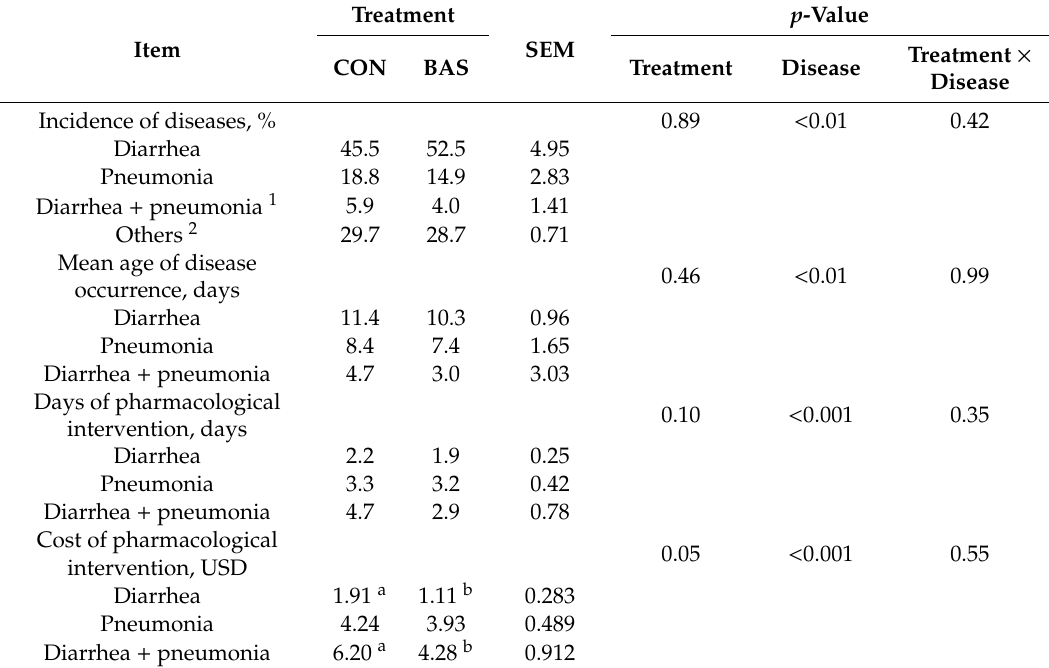
Table 2. Incidence of diseases, mean age of disease occurrence, days of pharmacological intervention required, and cost per head of pharmacological interventions of female Gir × Holstein female calves receiving (BAS; n = 70) or not receiving (CON; n = 70) a bovine appeasing substance every 14 days during pre-weaning and diagnosed with any disease during the experimental period 1 . p -Value Treatment Item SEM Treatment × CON BAS Treatment Disease Disease Incidence of diseases, % 0.89 < 0.01 0.42 Diarrhea 45.5 52.5 4.95 Pneumonia 18.8 14.9 2.83 Diarrhea + pneumonia 1 5.9 4.0 1.41 Others 2 29.7 28.7 0.71 Mean age of disease 0.46 < 0.01 0.99 occurrence, days Diarrhea 11.4 10.3 0.96 Pneumonia 8.4 7.4 1.65 Diarrhea + pneumonia 4.7 3.0 3.03 Days of pharmacological 0.10 < 0.001 0.35 intervention, days Diarrhea 2.2 1.9 0.25 Pneumonia 3.3 3.2 0.42 Diarrhea + pneumonia 4.7 2.9 0.78 Cost of pharmacological 0.05 < 0.001 0.55 intervention, USD Diarrhea 1.91 a 1.11 b 0.283 Pneumonia 4.24 3.93 0.489 Diarrhea + pneumonia 6.20 a 4.28 b